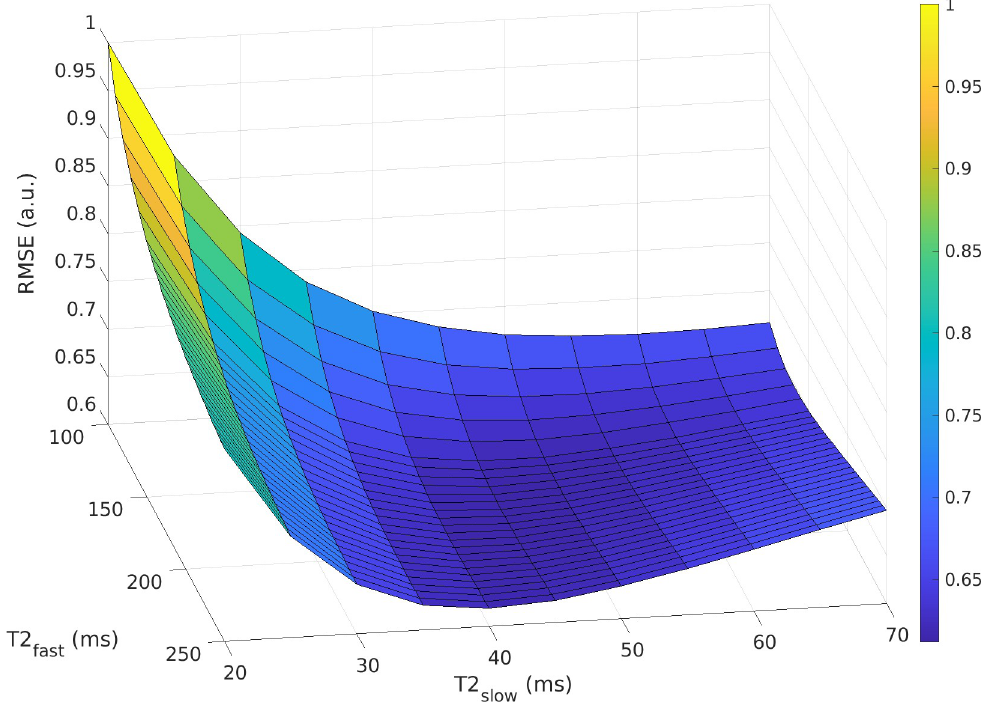
Fig 1. Surface curve showing the total root-mean-square error (RMSE) from fitting the two-component model with a range of T2 slow and T2 fast values for the training set, scaled so that the highest RMSE equals 1. The total RMSE is at a minimum for T2 slow = 45 ms and T2 fast = 180